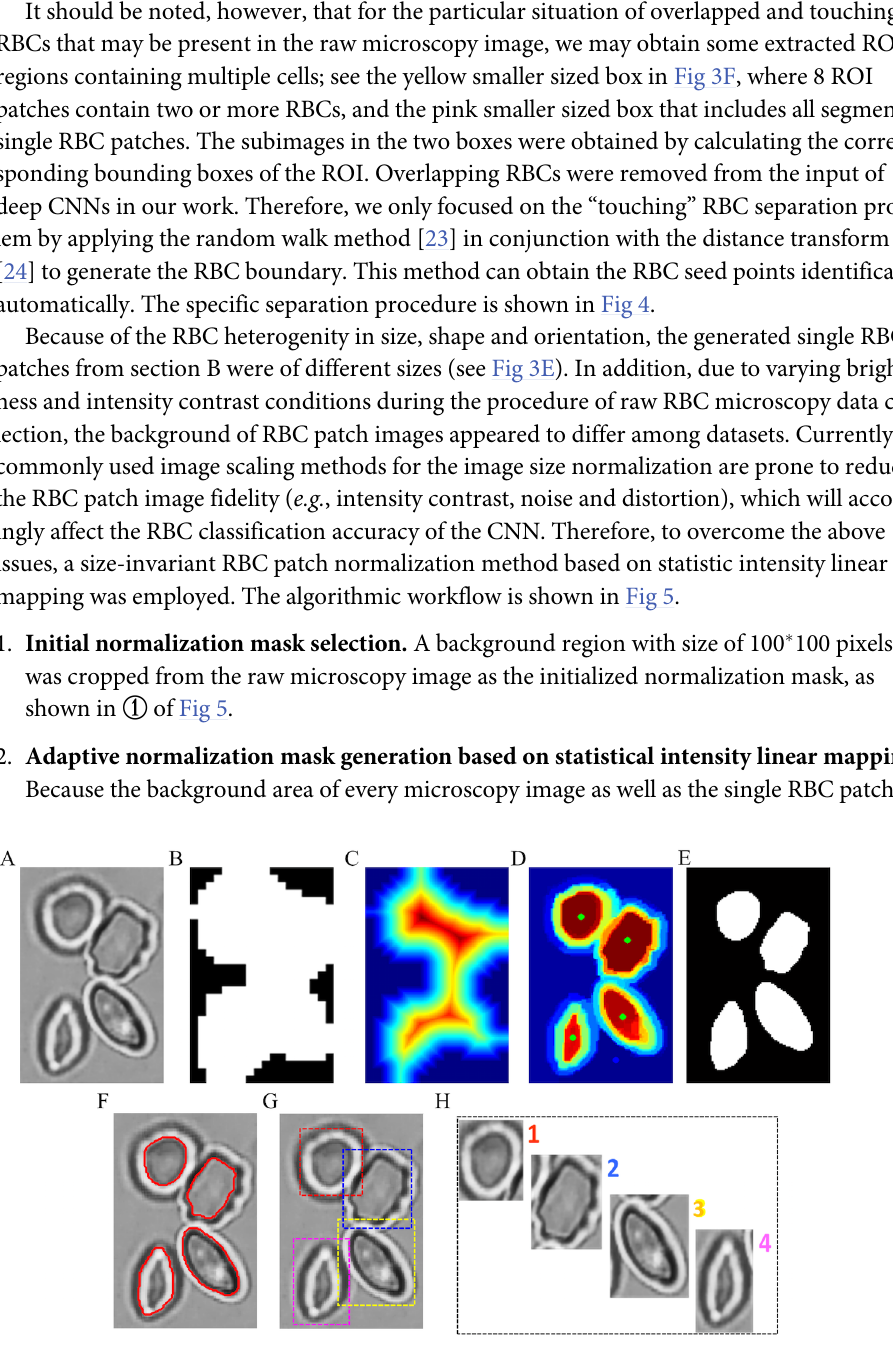
Fig 4. Workflow of RBC patch generation from ROIs with touching RBCs. (A) ROI patch. (B) binary ROI mask image. (C) Euclidean distancetransfrom result. (D) Probabilitymap based on randomwalk method with seeds (green dots) obtained from distancetransform result. (E) separatedRBC binarymask. (F) segmented RBC outlines (red line). (G) boundingboxes of single RBCs. (H) The touchingRBCs are separated into four singleRBC